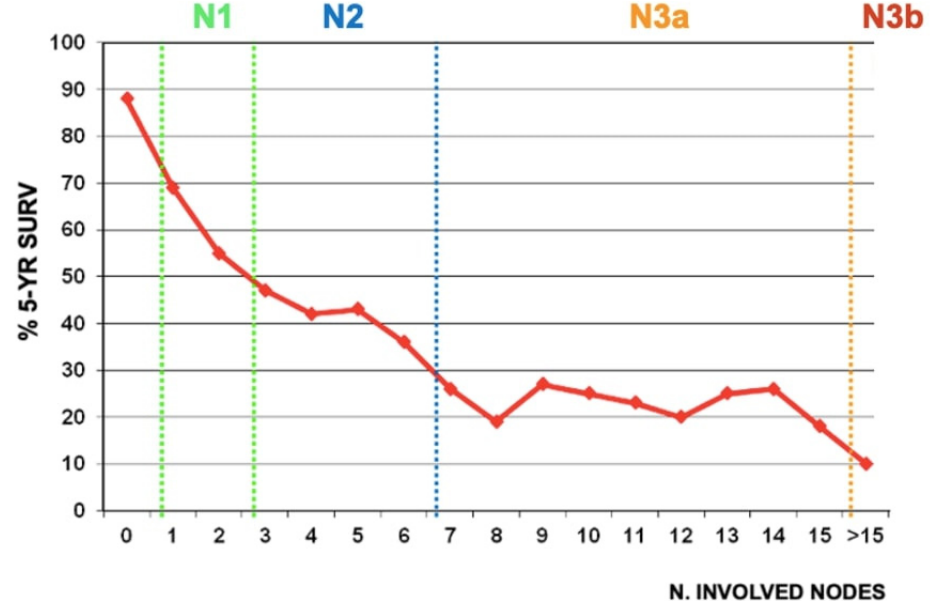
Figure 2. Correlation between the number of metastatic nodes and 5-year overall survival in GIRCG cohort. “N” classification according to the 8th Edition of the AJCC is showed in subgroups.